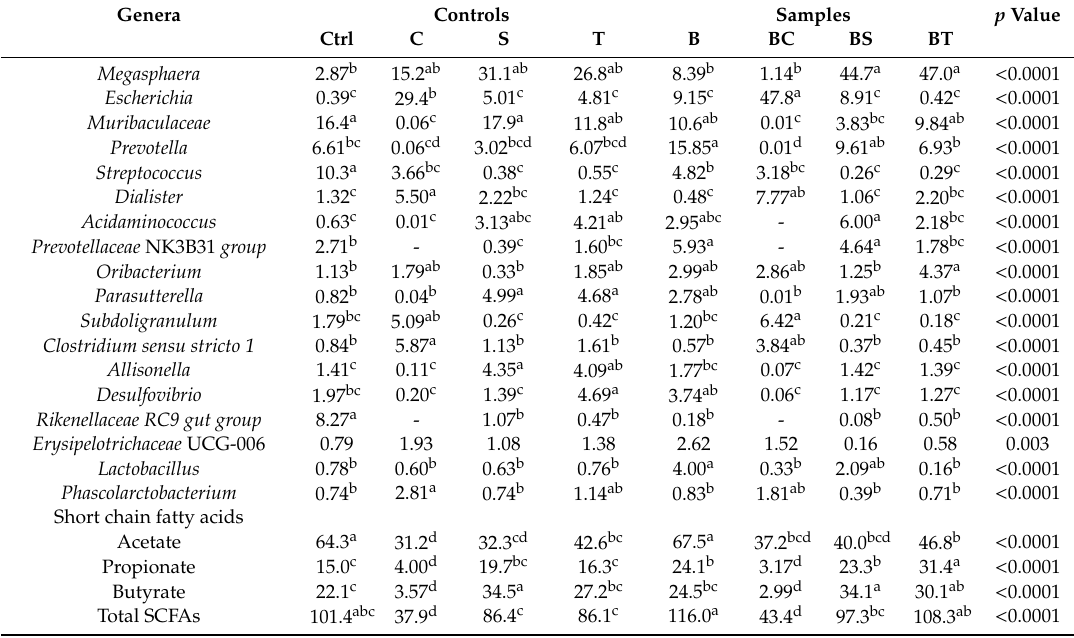
Table 3. Relative abundance (%) of microbiota ( > 1%) and short chain fatty acid (SCFA) productions (mmol / L) of controls and samples after colonic